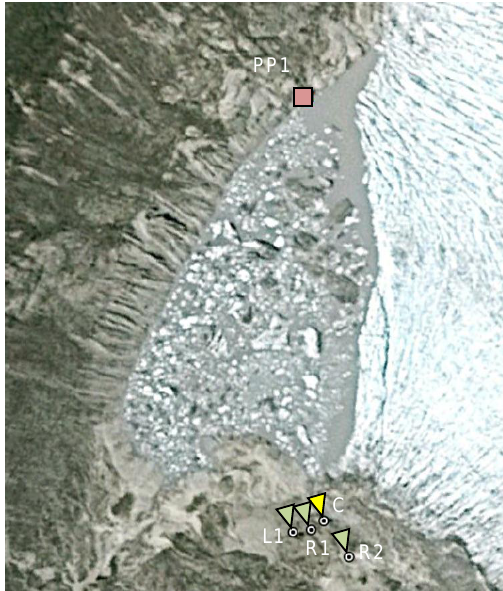
Figure 6. Photogrammetric network design on Lago Nef Norte with time lapse camera (C - with field of view in dark red) and the images (with field of view in yellow) for georeferencing (L1, R1, R2). Point PP-1 is a control point on the opposite lake front (900m from camera C)